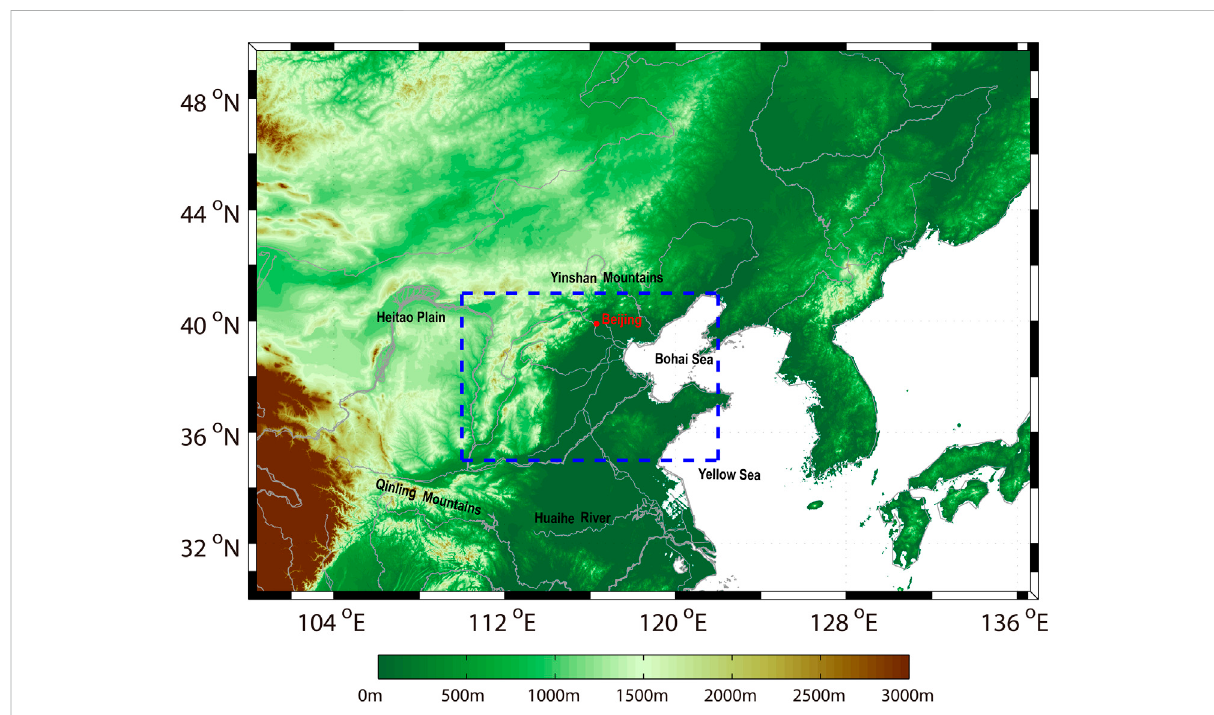
FIGURE 1 The topography around North China; the altitude (unit: m) is shaded. The box (35 ° N – 41 ° N, 110 ° N – 122 ° E) shows the region of North